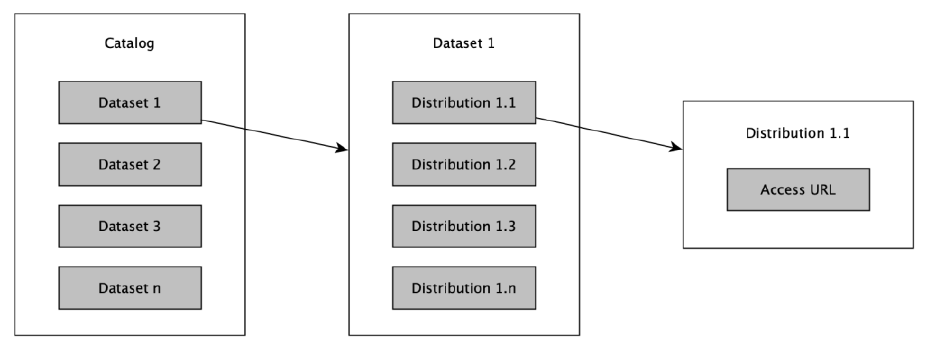
Figure 1: Parts of the knowledge graph (arrows symbolise links) A dataset contains two mandatory metadata fields, Title and Description . Both are literals. A literal is a string of characters and/or numerical values that are saved in a human-readable format. Op- tionally, a language tag can be added to the end of each literal. For a definition, see (Phillips and Davis, 2009). For instance, ‘"This is a sample literal"@en’ is a serialised representation. The text is in inverted commas, and the language tag is indicated with an @